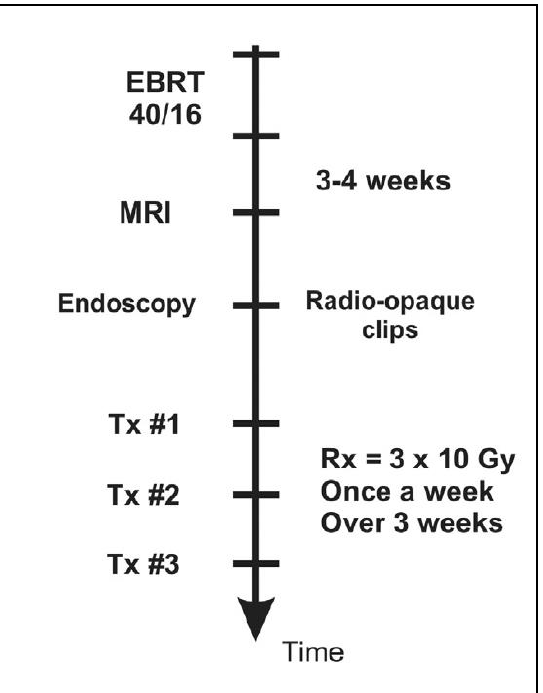
Figure 6. Workflow of brachytherapy boost for inoperable rectal cancer patients consisting of three treatment fractions given as one fraction per